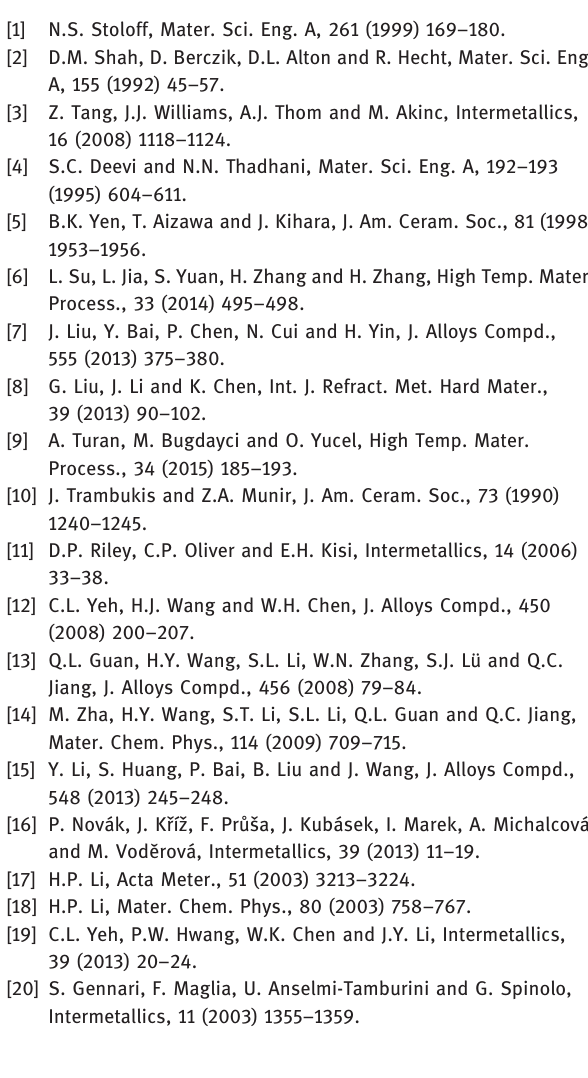
Figure 6: A comparison between measured and calculated flame- front velocities as functions of sample density and k eff / k bulk for combustion synthesis of Ti 5 Si 3